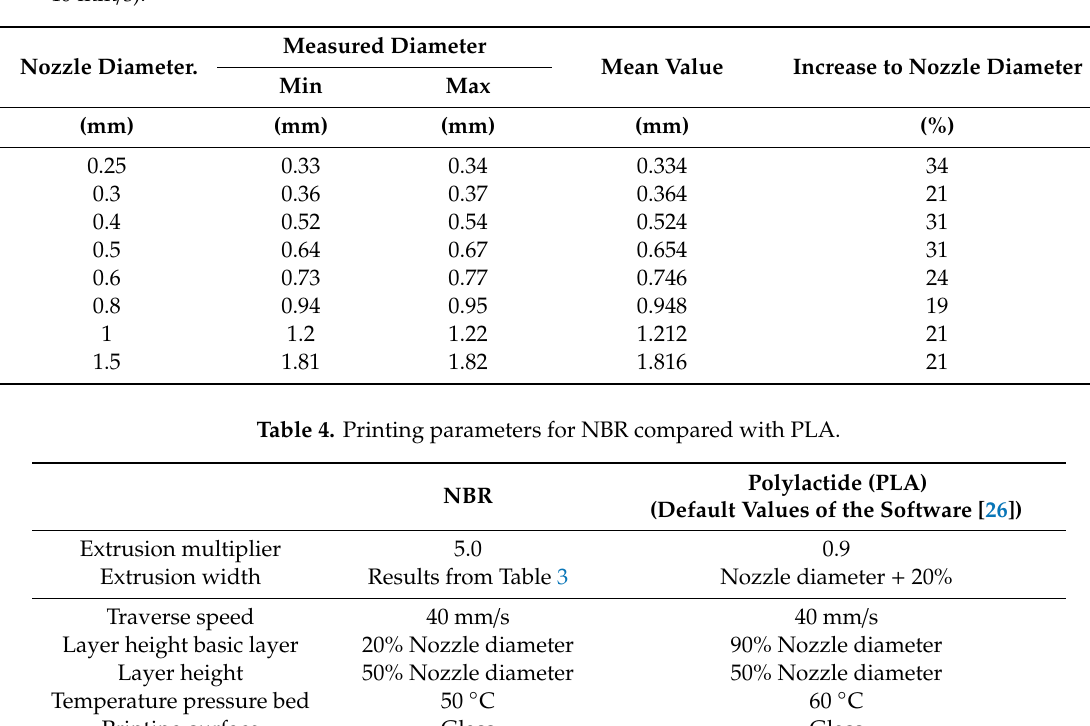
Table 3. The measurement results for the strand diameter after the nozzle outlet (with a printing speed 40 mm / s).